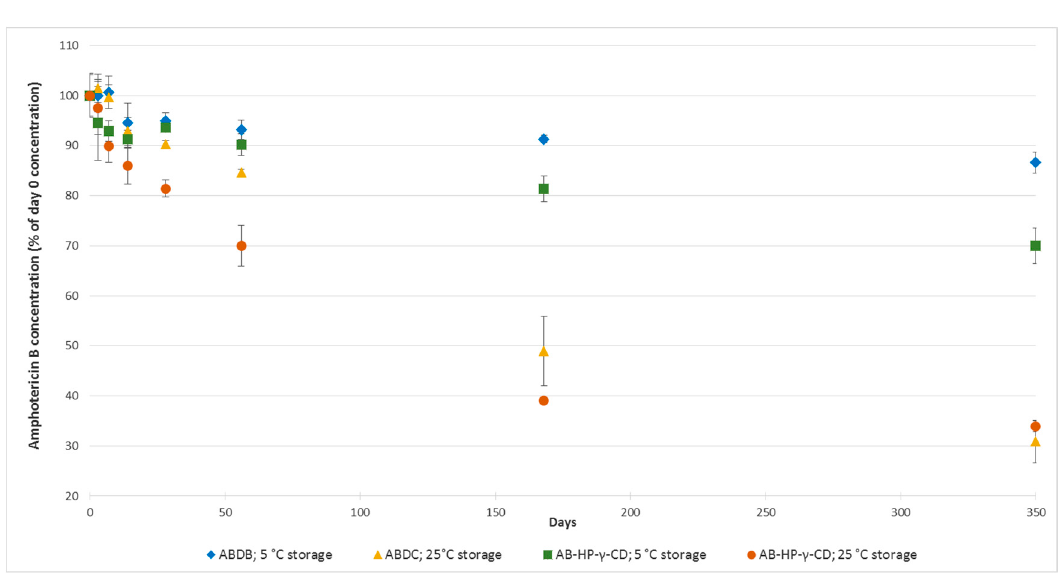
Figure 3. Evolution over time of amphotericin B concentrations for the amphotericin B deoxycholate (ABDC) and amphotericin B 2-hydroxypropyl- γ -cyclodextrin (AB-HP- γ -CD) formulations. n = 4, mean ± 95% confidence interval.